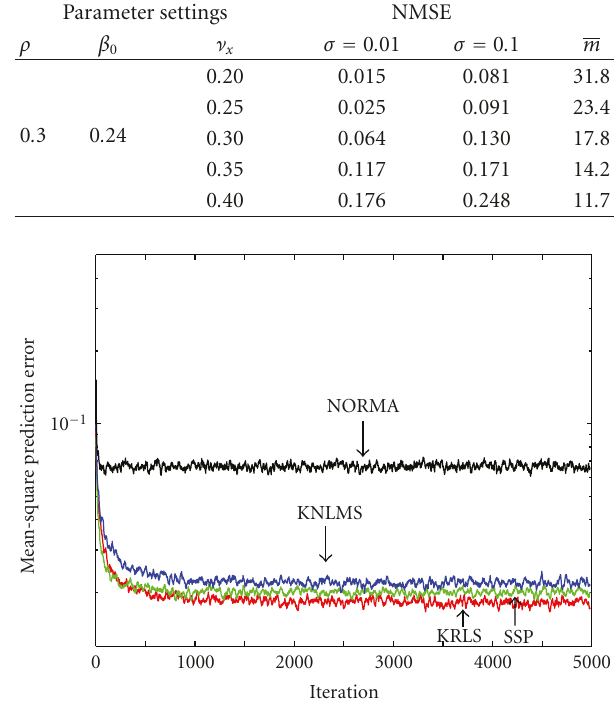
Figure 7: Learning curves for KNLMS, NORMA, SSP, and KRLS obtained by averaging over 200